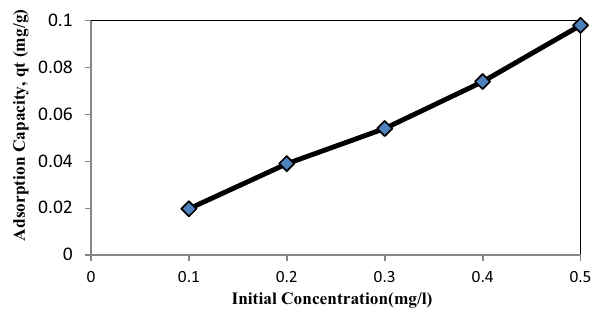
Fig. 3 Effect of initial arsenite concentration at 120 rpm, 30 °C and